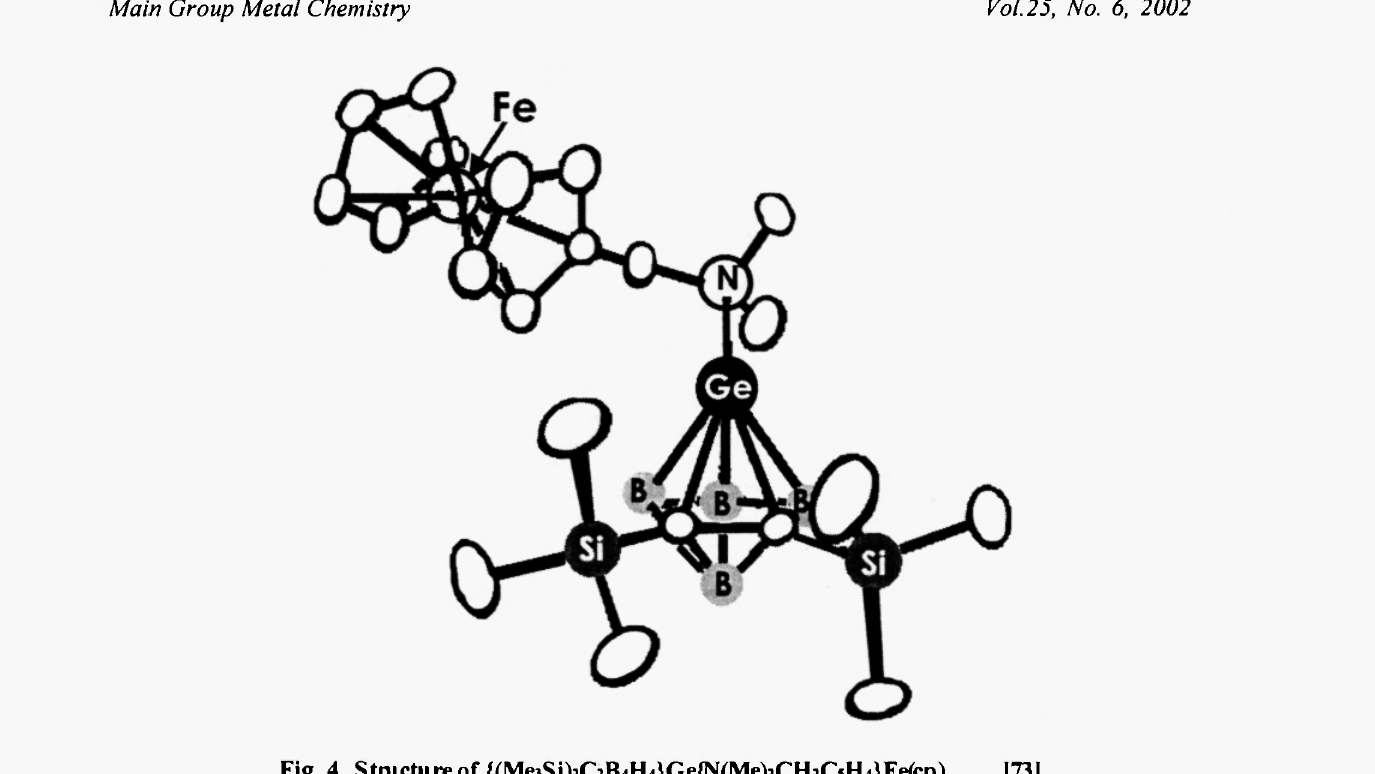
Fig. 4. Structure of {(Me>Si)2C2B4H4}Ge{N(Me)2CH2C 5 H4}Fe(cp) |73|